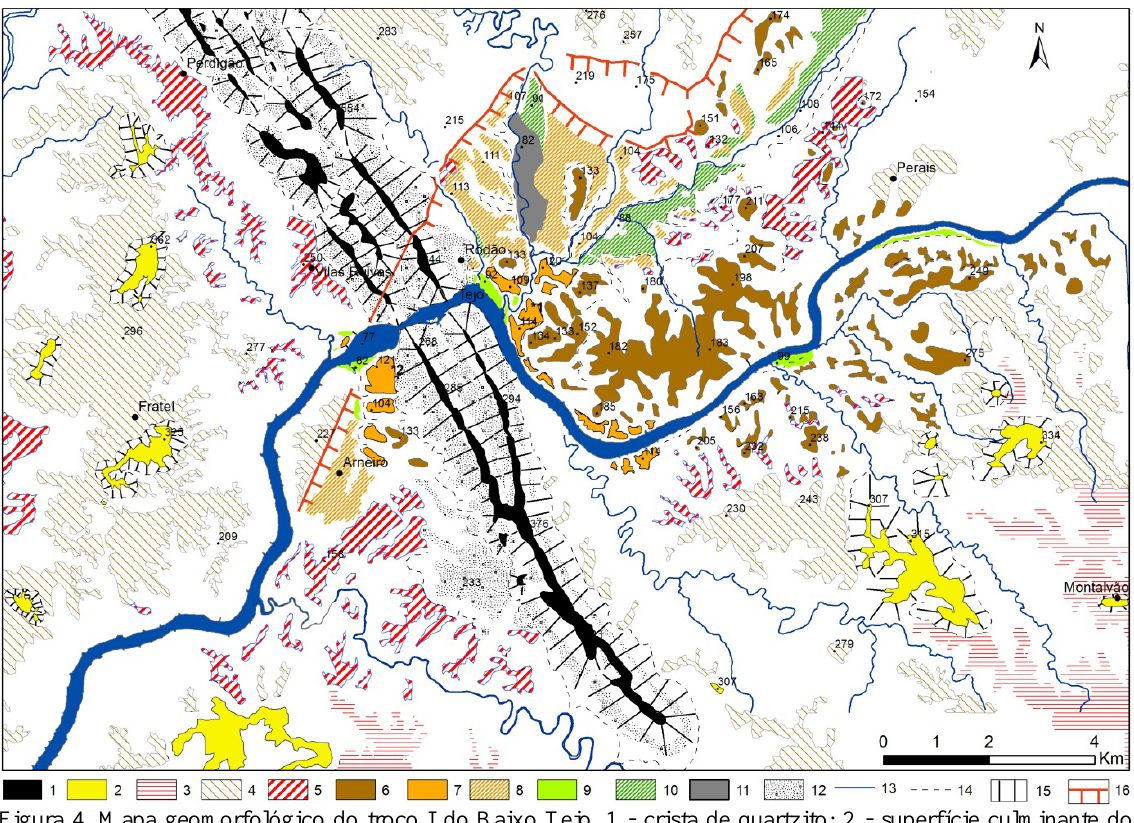
Figura 4. Mapa geomorfológico do troço I do Baixo Tejo. 1 - crista de quartzito; 2 - superfície culminante do enchimento sedimentar da Bacia Cenozóica do Baixo Tejo; 3 - superfície de aplanamento do Sul de Portugal (Meseta Ibérica); 4 - nível de erosão N1; 5 - nível de erosão N2; 6 - terraços superiores (T1, T2 e T3); 7 - terraço T4; 8 - nível de erosão correlativo do terraço T4; 9 - terraços inferiores (T5 e T6); 10 - nível de erosão correlativo dos terraços inferiores; 11 - planície aluvial (Holocénico); 12 - depósito de vertente; 13 - curso de água; 14 - base de vertente; 15 - vertente; 16 - escarpa de falha. Figure 4. Geomorphological map of the reach I, in the Lower Tejo. 1 - quartzite ridge; 2 - culminant surface of the sedimentary infill of the Lower Tejo Cenozoic Basin; 3 - planation surface of Southern Portugal (Iberian Meseta); 4 - N1 erosion surface; 5 - N2 erosion surface; 6 - upper terraces (T1, T2 and T3); 7 - T4 terrace; 8 - erosion surface correlative of T4 terrace; 9 - lower terraces (T5 and T6); 10 - erosion surfaces correlative of the lower terraces; 11 - alluvial plain (Holocene); 12 - slope deposits; 13 - stream; 14 - slope base; 15 - slope; 16 - fault